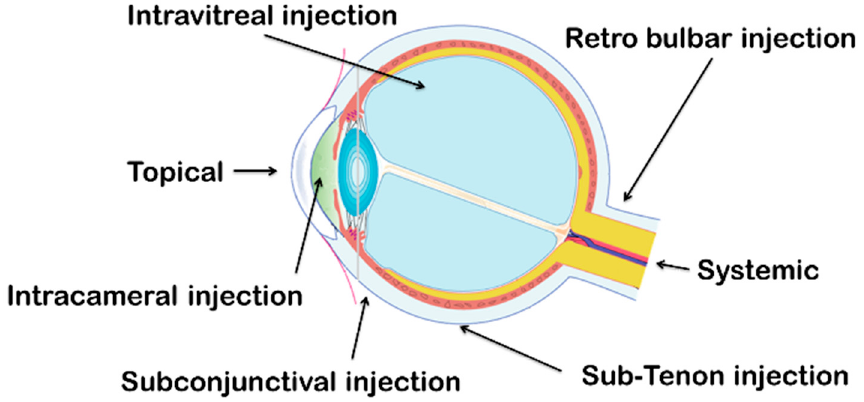
Figure 2. Routes of ocular administration.